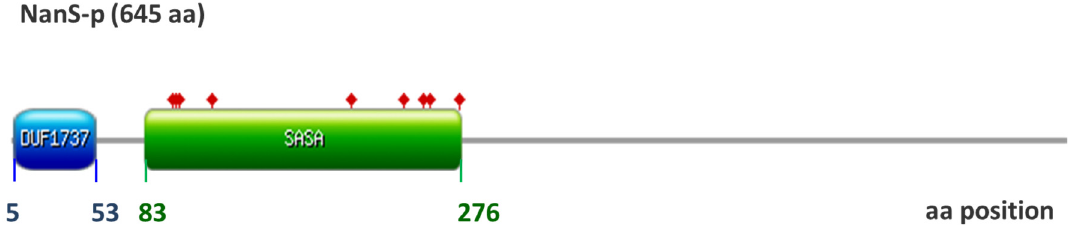
Figure 1. Graphical view of domains identified in NanS-p sequences. Numbers refer to the amino acid positions in the 933W NanS-p sequence (AAD25447.1). Red diamonds indicate the main variable positions in the sialic acid-specific acetylesterase (SASA) domain. The scheme of the protein was generated with ExPASy PROSITE MyDomains Image Creator